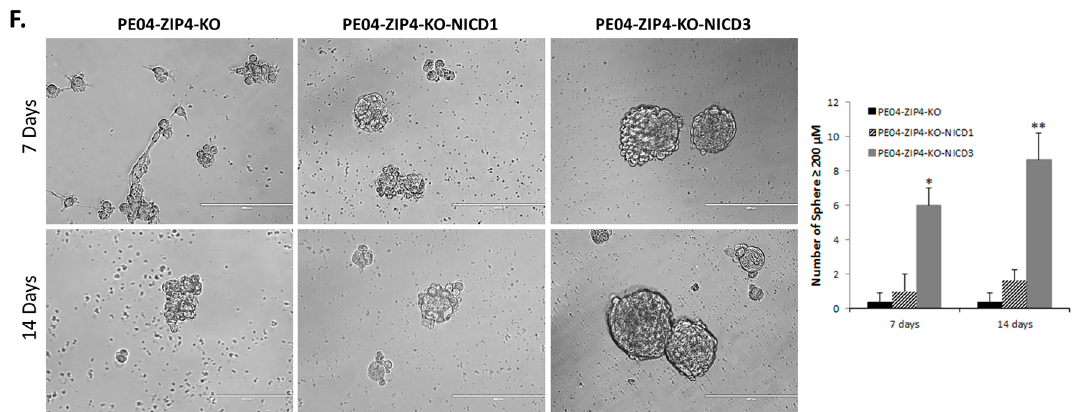
Figure 5. ZIP4 upregulated NOTCH3 expression and NOTCH3 was a functional downstream mediator of ZIP4. ( A ) Overexpression of ZIP4 increased NOTCH3 expression. ( B ) Knockout of ZIP4 reduced NOTCH3 expression. ( C ) Knockout of NOTCH3 in PE04 cells did not a ff ect its ZIP4 expression. The uncropped Western blot images for (A) to (C) are shown in the Figure S2. ( D ) Knockout of NOTCH3 inhibited spheroid formation in PE04 cells. The bar graph depicts numbers of spheroid ( ≥ 200 µ m) developed from PE04 and PE04-Notch3-KO from three independent studies. ( E ) Anti-NOTCH3 and anti-Jag1 neutralizing antibodies (0.25 UG / well) blocked the ability of spheroid formation in PE01-ZIP4-OE and PE04 cells, with 6 days of treatment. ( F ) NOTCH3 intracellular domain (NICD3), but not NICD1, reversed most spheroid-formation capacity in ZIP4-KO cells. The bar graph depicts numbers of spheroids ( ≥ 200 µ m) formed from PE04-ZIP4-KO control, PE04-ZIP4-KO transfected with NICD1 or NICD3 in 7 days and 14 days, respectively (average ± SD). Representative results are shown for more than three independent experiments. Scale bar = 400 µ m. * p < 0.05 and ** p < 0.01.